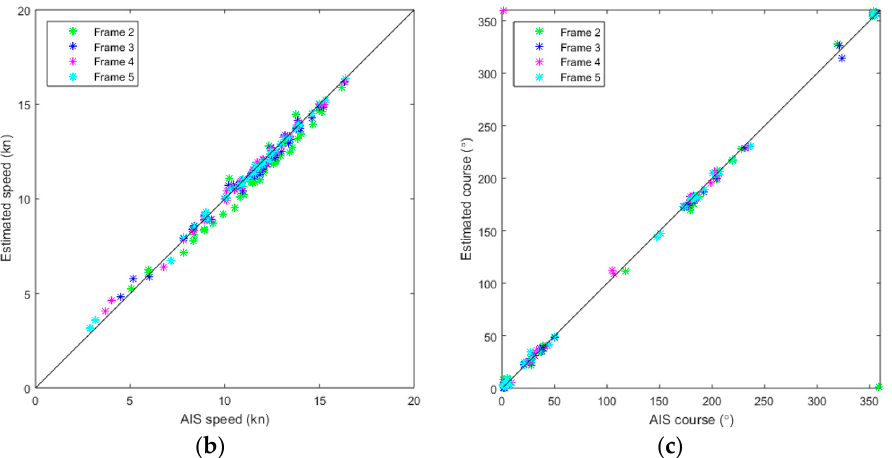
Figure 15. The proximity of motion states between the tracking results and AIS data in five frames: ( a ) location error between estimated positions and AIS positions; ( b ) estimated speed with regard to AIS speed; ( c ) estimated course with regard to AIS course. Table 2. Comparison of estimation error of motion states.